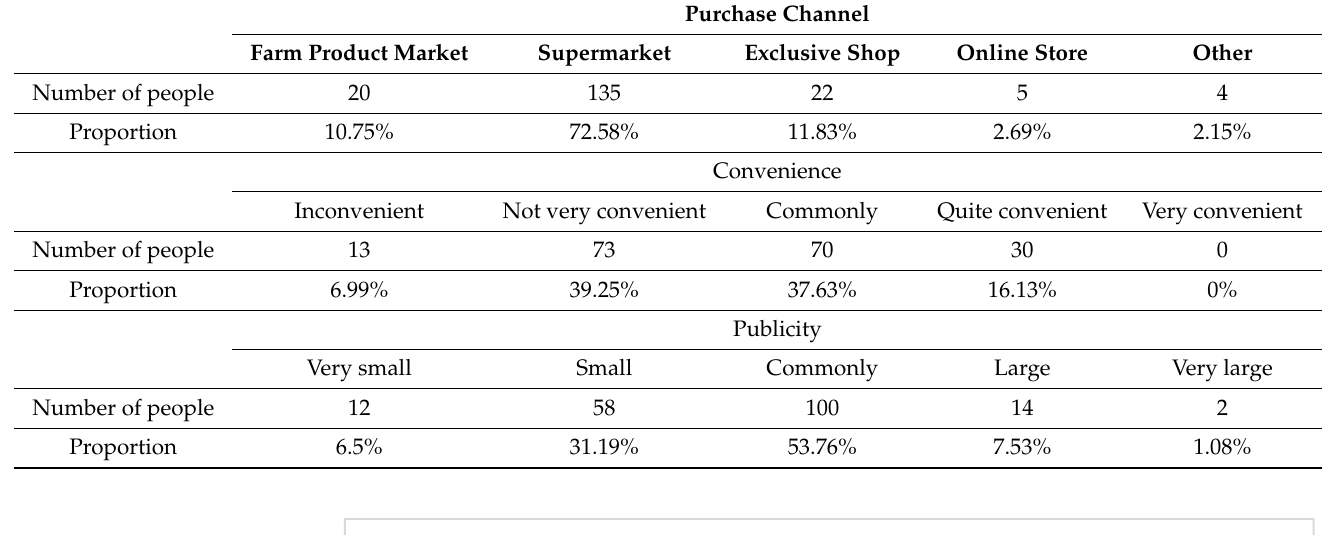
Table 4. Statistical table of consumers’ description of organic agricultural products and market conditions.